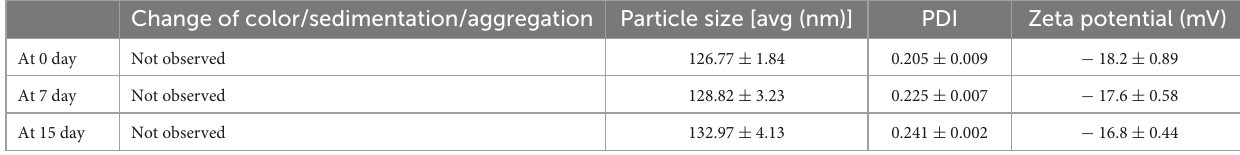
TABLE 1 Physical stability parameters for